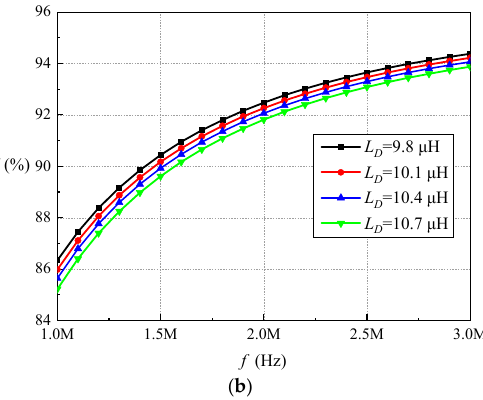
Figure 11. Relationship between the detection sensitivity S and excitation frequency f when the coin was in the center area of detection coil: ( a ) Broad frequency band; ( b ) Zoomed details of the red dotted square part in Figure 11a.